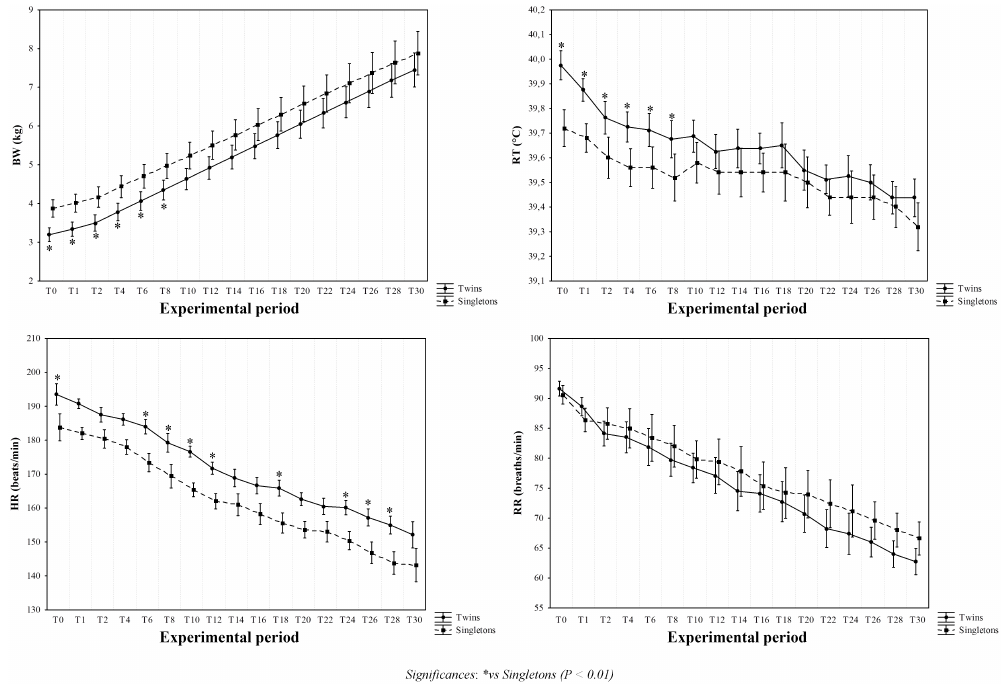
Figure 2. Mean values of body weight (BW), rectal temperature (RT), heart rate (HR) and respiratory rate (RR) obtained from singleton and twin kids during the first month of life. Vertical bars denote ± 95% confidence